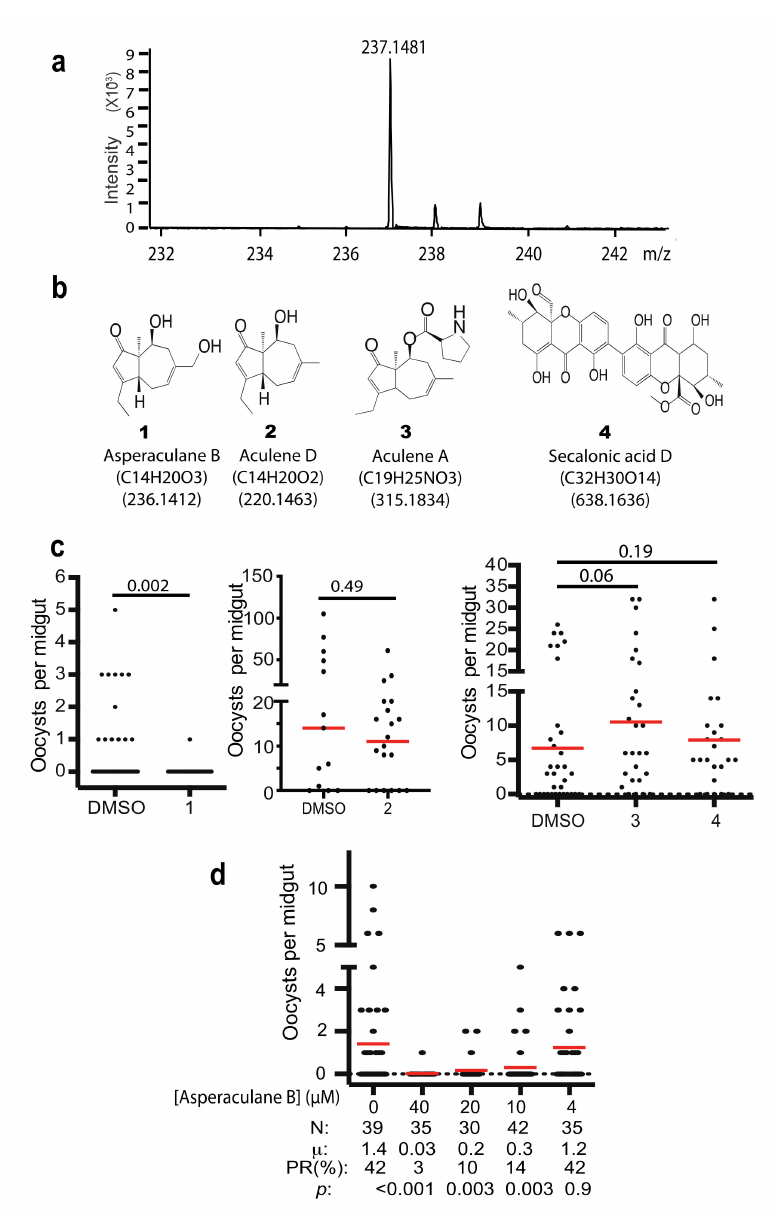
Figure 6. Identification of the active compound. ( a ) The high-resolution mass spectrometry of the HPLC purified compound with a proton (236.1403 + 1.0078 = 237.1481). ( b ) Four purified and identified compounds from A. aculeatus from other research labs [12,14]. ( c ) The transmission-blocking activities of four compounds. ( d ) The transmission-blocking activity of serial dilution of asperaculane B. N: # of mosquitoes for each treatment; µ : the mean oocysts per midgut; PR: infection prevalence in mosquitoes; p : The statistical p values of each concentration comparing to the control (concentration was